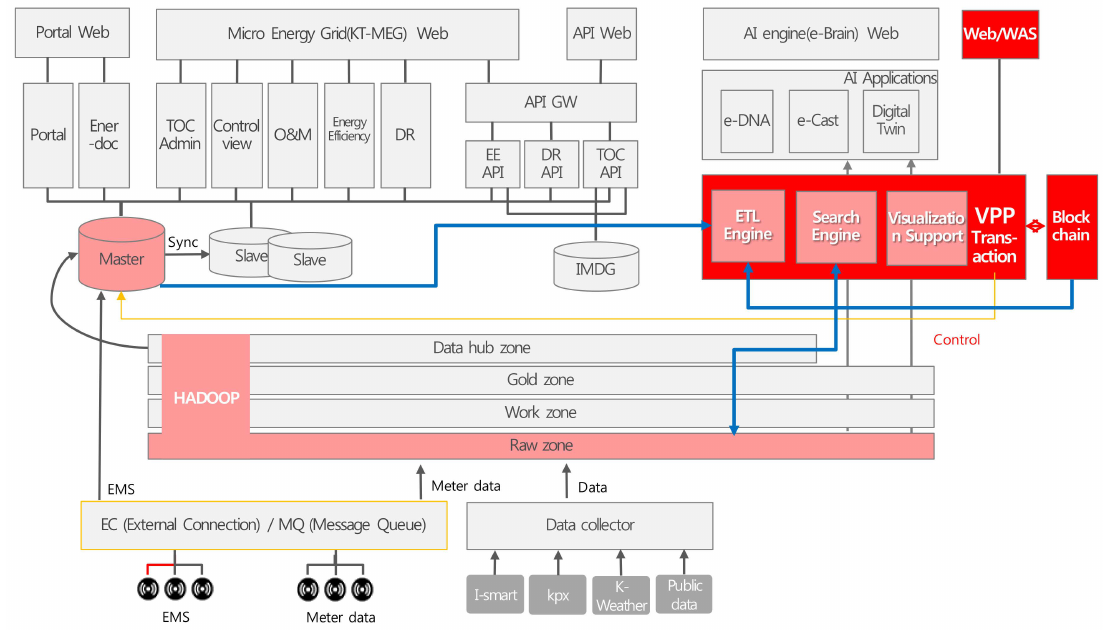
Figure 15. Diagram of big data platform and virtual power plant (VPP) proof of concept (PoC)